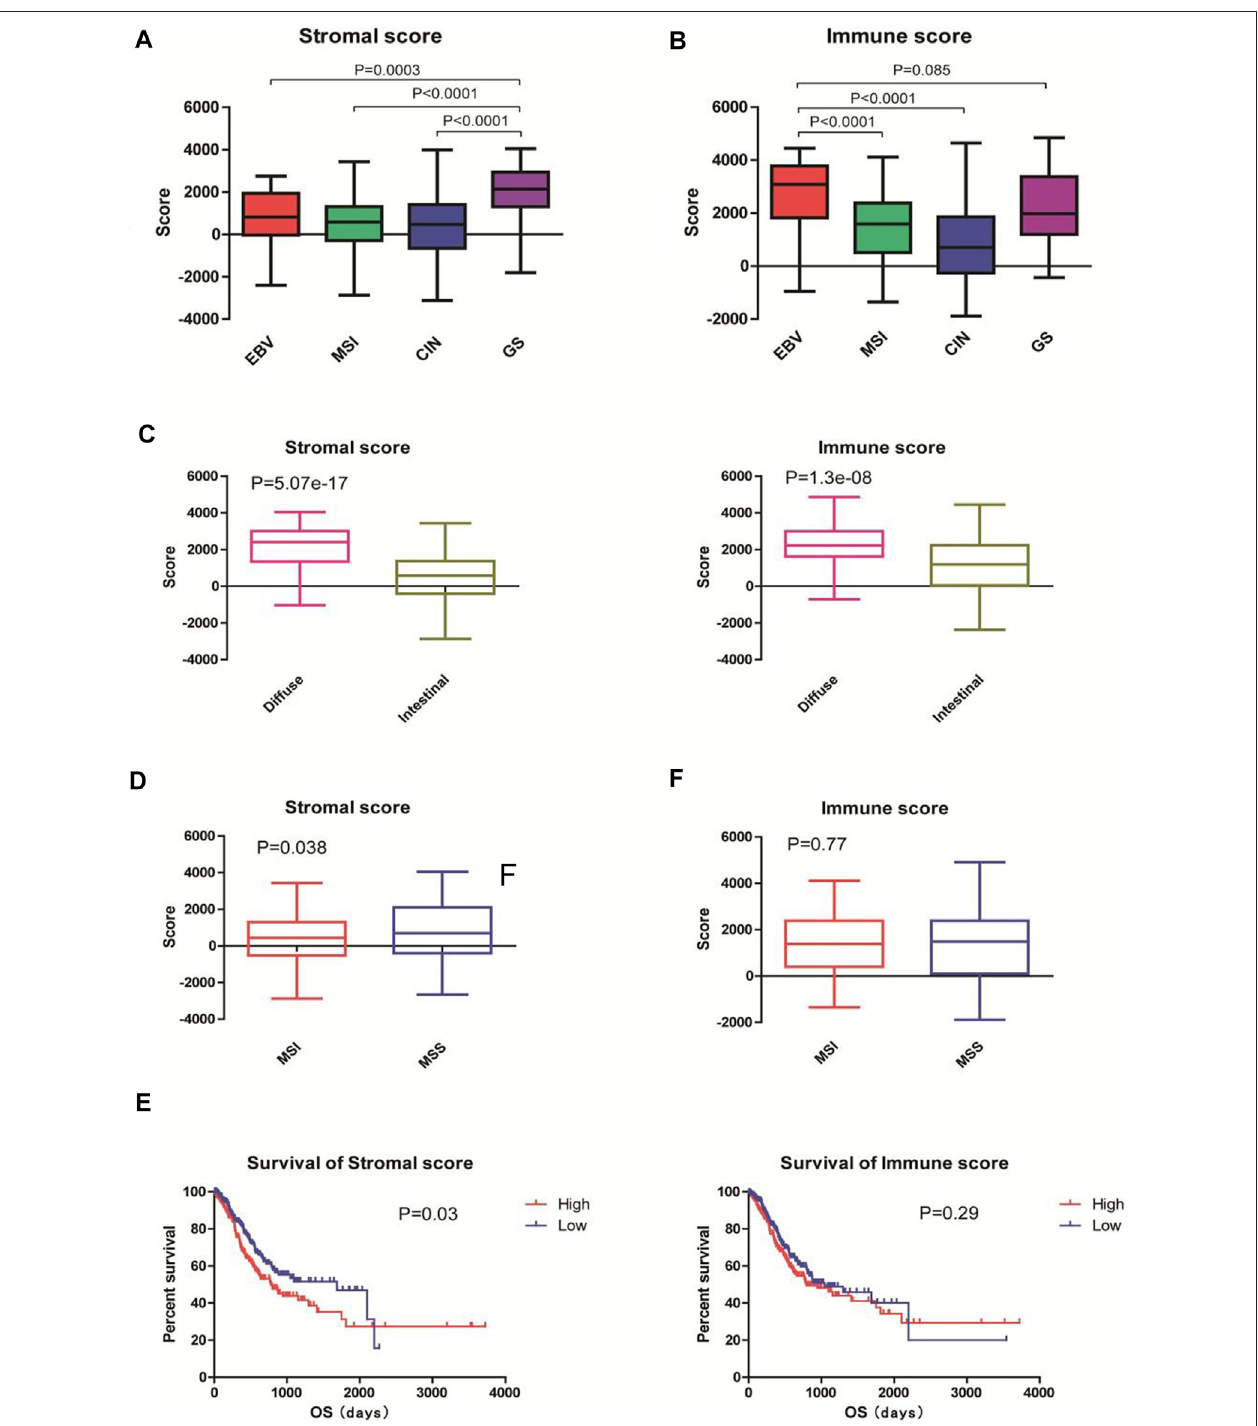
FIGURE1| Immuneandstromalscoreswereassociatedwiththeclassi fi cationandprognosisofgastricadenocarcinoma.Thegeneexpressionpro fi lesandclinical characteristics of 388 patients with gastric adenocarcinoma were obtained from the TCGA database. The immune and stromal scores of each sample were acquired from theEstimation ofSTromal and Immune cells in MAlignant Tumor tissues using Expression data (ESTIMATE; http://bioinformatics.mdanderson.org/estimate). (A,B) Tumors were classi fi ed into EBV ( n (cid:1) 30), MSI ( n (cid:1) 73), CIN ( n (cid:1) 223), and GS ( n (cid:1) 50) subtypes according to TCGA classi fi cation in 2014. The stromal scores and immune scores are shown. (C) Tumors were classi fi ed into intestinal-type ( n (cid:1) 66) and diffuse-type ( n (cid:1) 181) tumors according to the Lauren classi fi cation. The stromal scores and immune scores are shown. (D) Tumors were classi fi ed into MSI ( n (cid:1) 79) and MSS ( n (cid:1) 276) tumors according to the Asian Cancer Research Group classi fi cation. The stromal scores and immune scores are shown. EBV: Epstein-Barr virus; MSI: microsatellite instable; CIN: chromosomal instability; GS: genomically stable; MSS: microsatellite stable. (E) Patients were divided into high- ( n (cid:1) 196) and low-score ( n (cid:1) 192) groups according to the mean stromal and immune scores. Kaplan-Meier survival analysis was performed to examine the correlations of stromal scores (left) and immune scores (right) with the overall survival of patients.